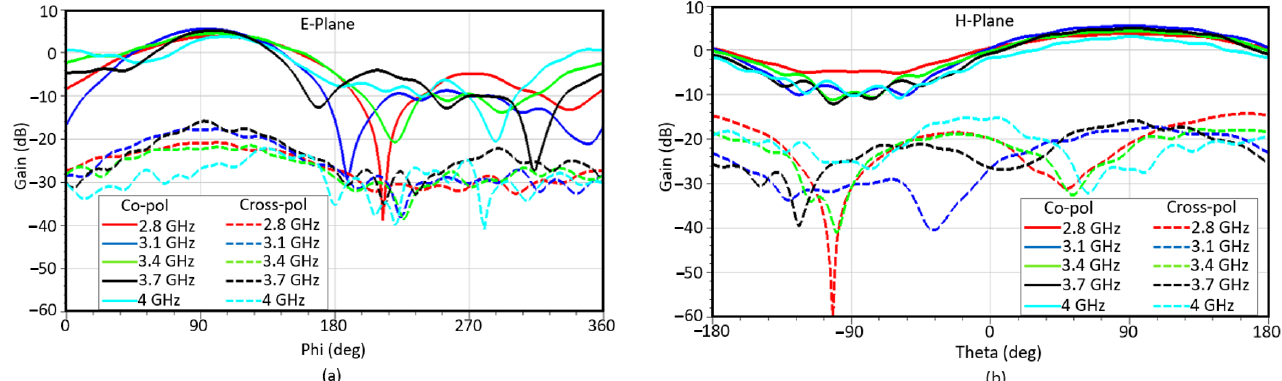
Figure 7. Co- and cross-polarized radiation patterns of the proposed antenna 1 in the ( a ) E (XY)-plane and ( b ) H (YZ)-plane.